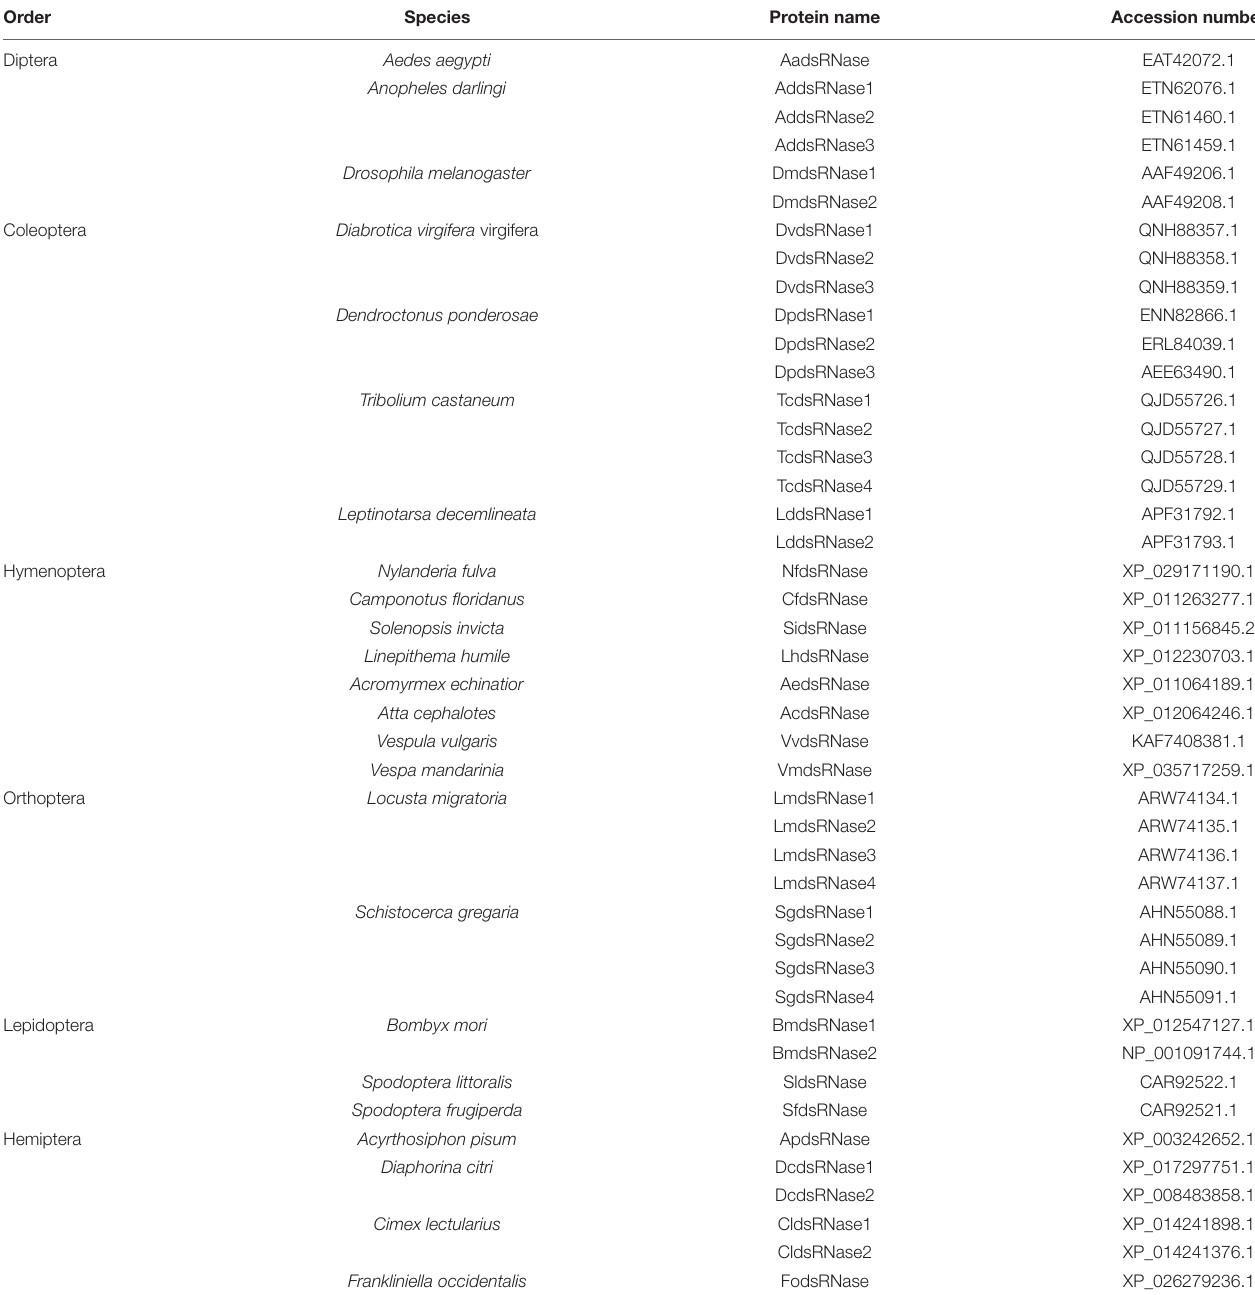
TABLE 2 | NCBI accession numbers of amino acid sequences used to construct the phylogenetic